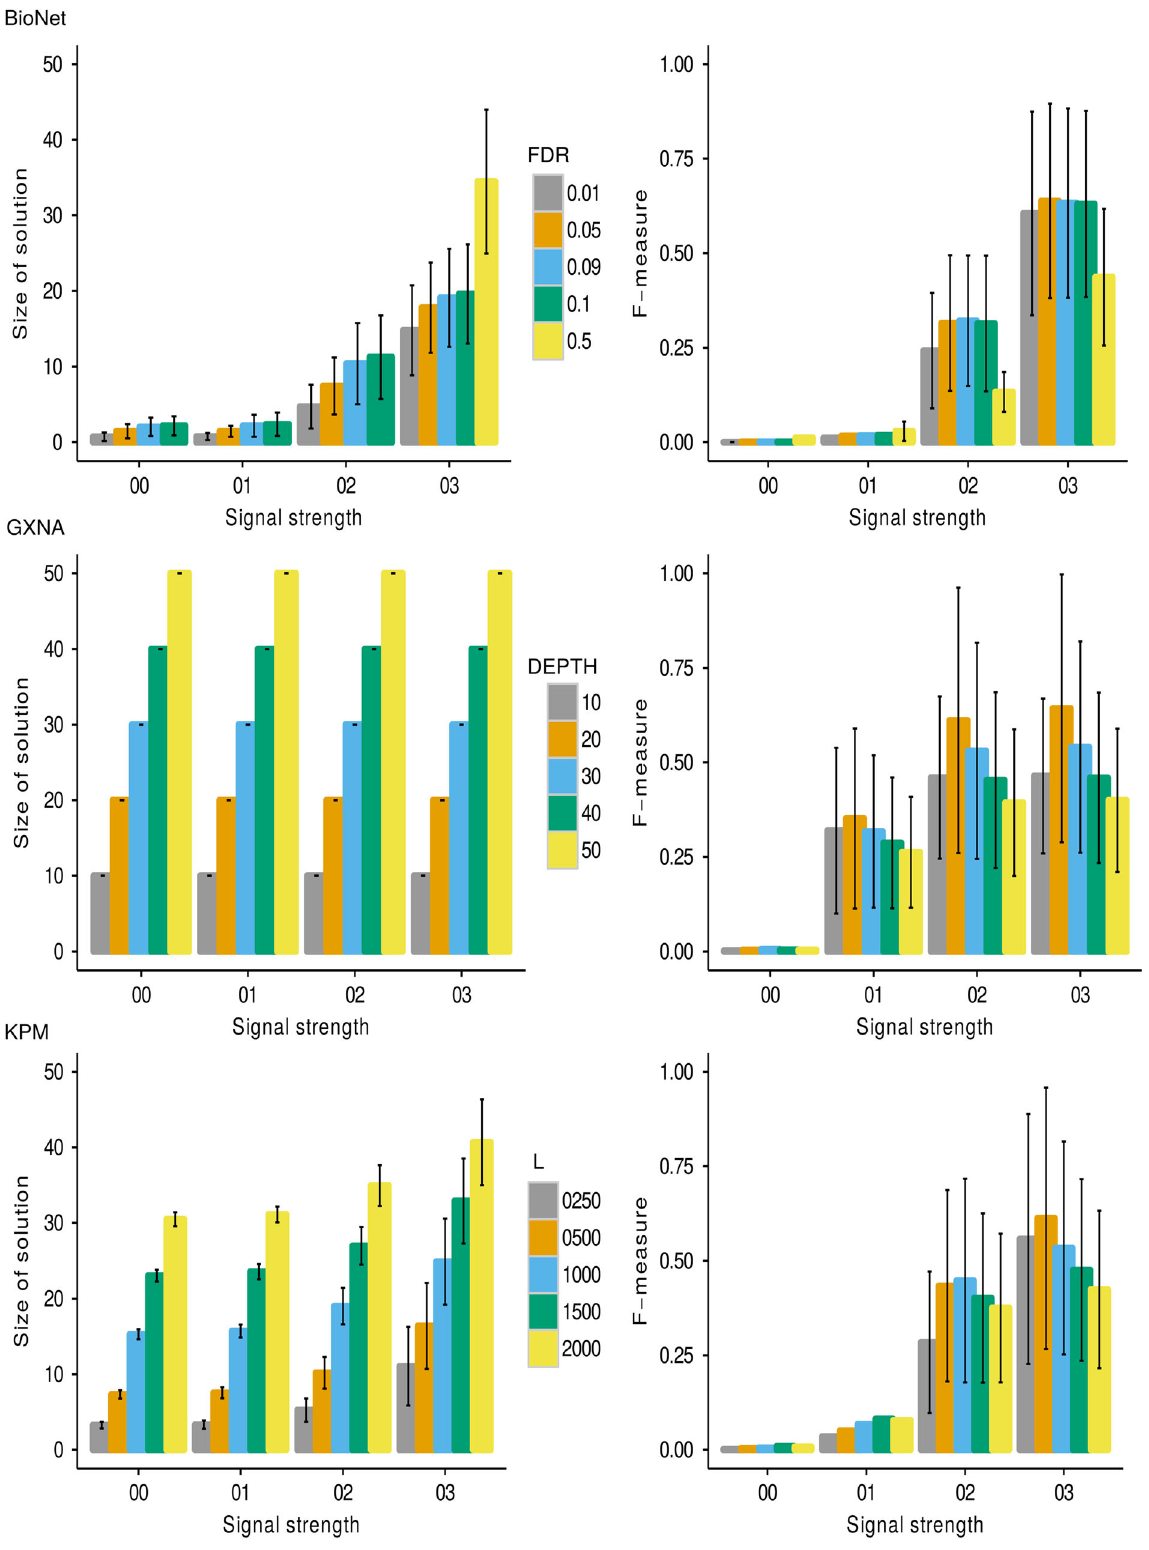
Fig. 3 Average performance for over 80 FG sets of size 20 nodes generated using the AVD k algorithm. Expression pro fi les were simulated with VM. The HPRD network was used as the input network. Performance was assessed with the F-measure for a range of internal parameter settings for each tool, i.e. the expected pathway size (M) for GXNA, the number of allowed exceptions (outliers) in a pathways (L) for KPM, and the pathway false discovery rate (FDR) for